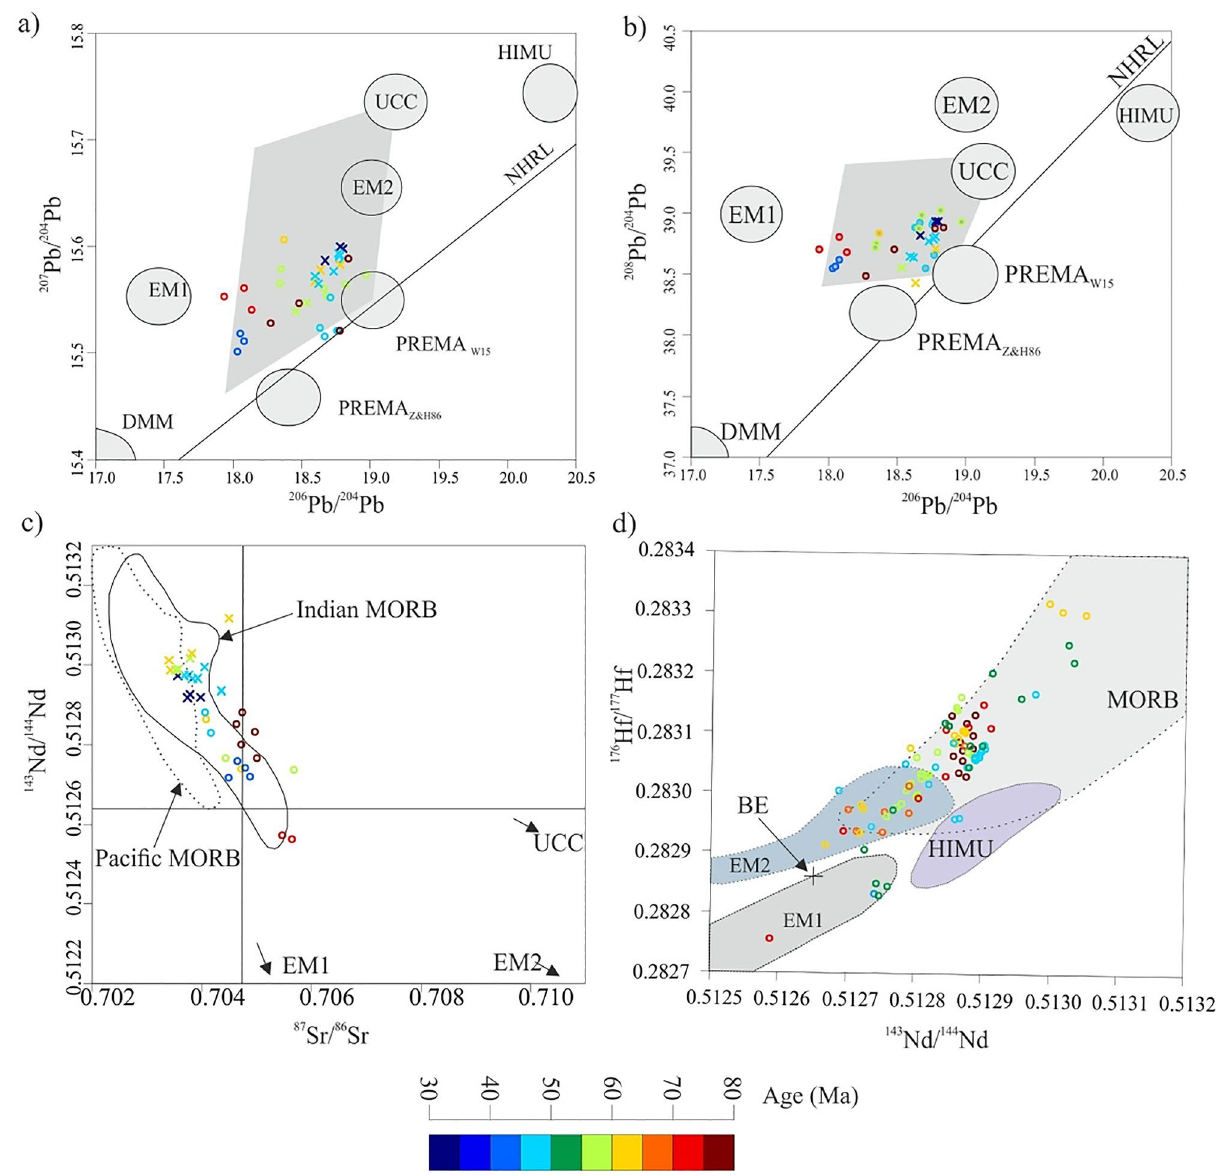
Figure 5. The isotopic signature of the NER basalts. ( a,b ) 207 Pb/ 204 Pb vs. 206 Pb/ 204 Pb and 208 Pb/ 204 Pb vs. 206 Pb/ 204 Pb; above the NHRL defines the DUPAL anomaly, enriched mantle 1 (EM1), enriched mantle 2 (EM2), upper continental crust (UCC), high U/Pb (HIMU), the prevalent mantle (PREMA W15 ) and (PREMA Z&H86 ) proposed by White 69 and Zindler and Hart 73 after Doucet et al. 71 , and depleted mantle (DMM). The NER basement rocks are similar to the deep African OIB, and plotted in the field of mixed PERMA W15 (prevalent mantle) + UCC (upper continental crust) 71 . ( c ) 143 Nd/ 144 Nd vs. 87 Sr/ 86 Sr, the NER basalts plot in the Indian MORB field. d , 176 Hf/ 177 Hf vs. 143 Nd/ 144 Nd, ca. 55 Ma basalts plot in two contrasting fields EM1 and